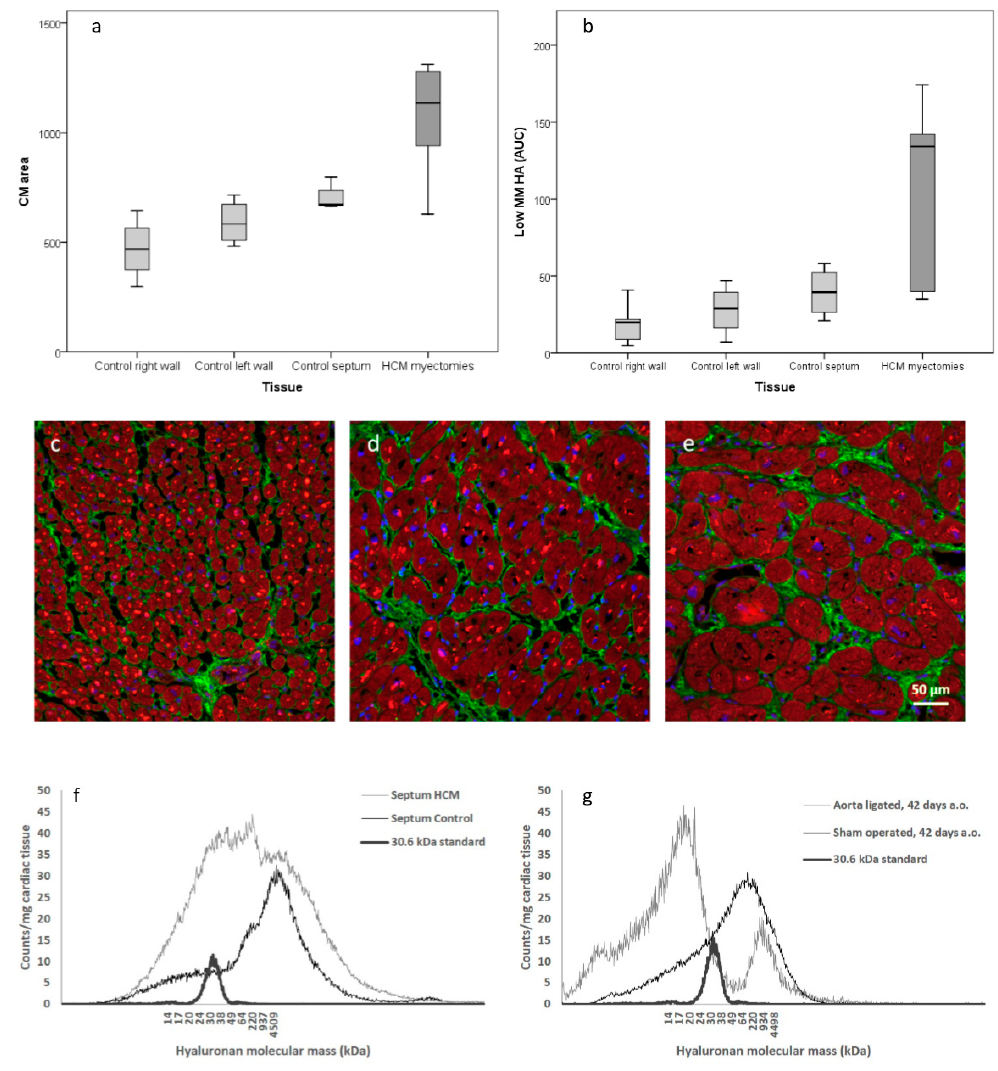
Figure 2. Cardiomyocyte (CM) size and amount of low molecular mass (MM) HA. Box plot illustrating cardiomyocyte size comparison between HCM and non-failing right wall septum and left wall, respectively ( a ). Box plot illustrating amount (corresponds to area under curve, AUC) of low MM HA in HCM and non-failing right wall septum and left wall, respectively ( b ). Immunohistochemistry of human heart tissues from right- ( c ), and left- ( d ) wall and HCM myectomies ( e ). The